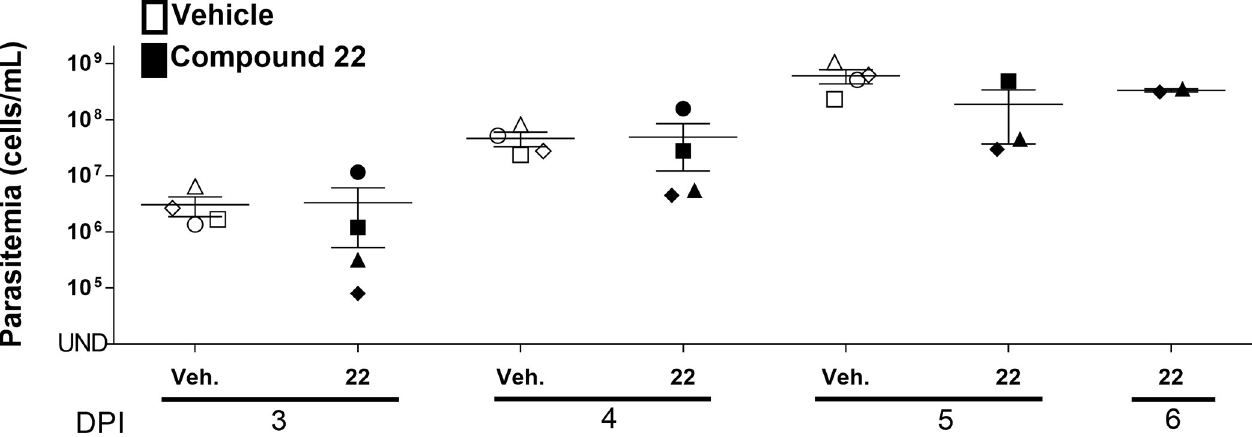
Fig 8. Parasitemia levels of T . b . brucei infected mice treated with 60 mg/kg 22 for the first three days post-infection before the dose was increased to 70 mg/kg for the remainder of the study, compared with the control group (10% NMP and 90% PEG only). Compound 22 and vehicle were administered once p.o. on Day 1 post-infection. Parasitemia in the blood collected from the tail vein was determined on Days 2–6 post-infection. UND: Undetectable parasitemia ( < 2 × 10 4 cells/mL), the black horizontal line in each group indicates the median parasitemia level. The different shapes are representative of each mouse in the group. NS: Not significant. The error bar indicates the standard error of the mean (SEM). The significance of the difference in the mean parasitemia of treated and untreated groups was analyzed by Student’s T-test.